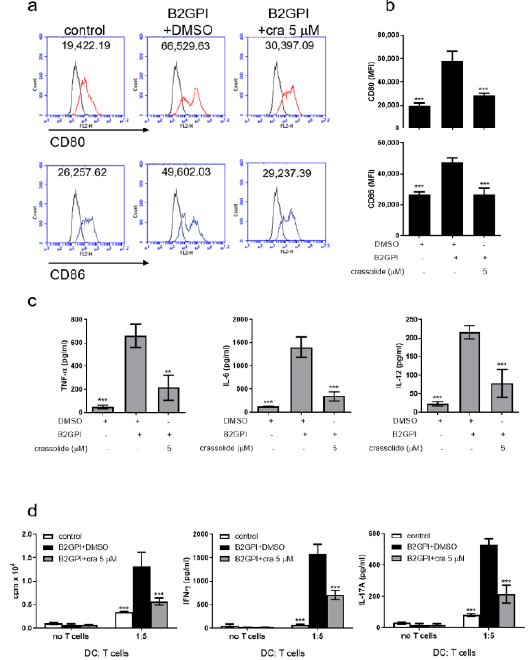
Figure 5. Effects of crassolide on the β 2GPI-stimulated BMDCs and T cells. ( a ) and ( b ) CD80 and CD86 expressions of BMDCs from bone marrows of naïve BALB/c mice were analyzed with flow cytometry. ( c ) TNF-α, IL-6, and IL-12 from BMDC cultured supernatant were measured by ELISA with or without crassolide treatment. ( d ) Cell proliferation and T-cell lineage cytokines of OT-II CD4+ T cells from OT-II mice was measured by 3 H-TdR incorporation assay after co-culturing with OVA 323–339 (OVAP 2 ) peptide and β 2GPI-stimulated BMDCs with or without crassolide treatment for 96 h. Data are presented as mean ± SEM of triplicate samples from one of three independent experiments. ** p < 0.01; *** p < 0.001, versus β 2GPI + 0.1% DMSO vehicle group and calculated with one-way ANOVA followed by Tukey’s multiple comparison test.